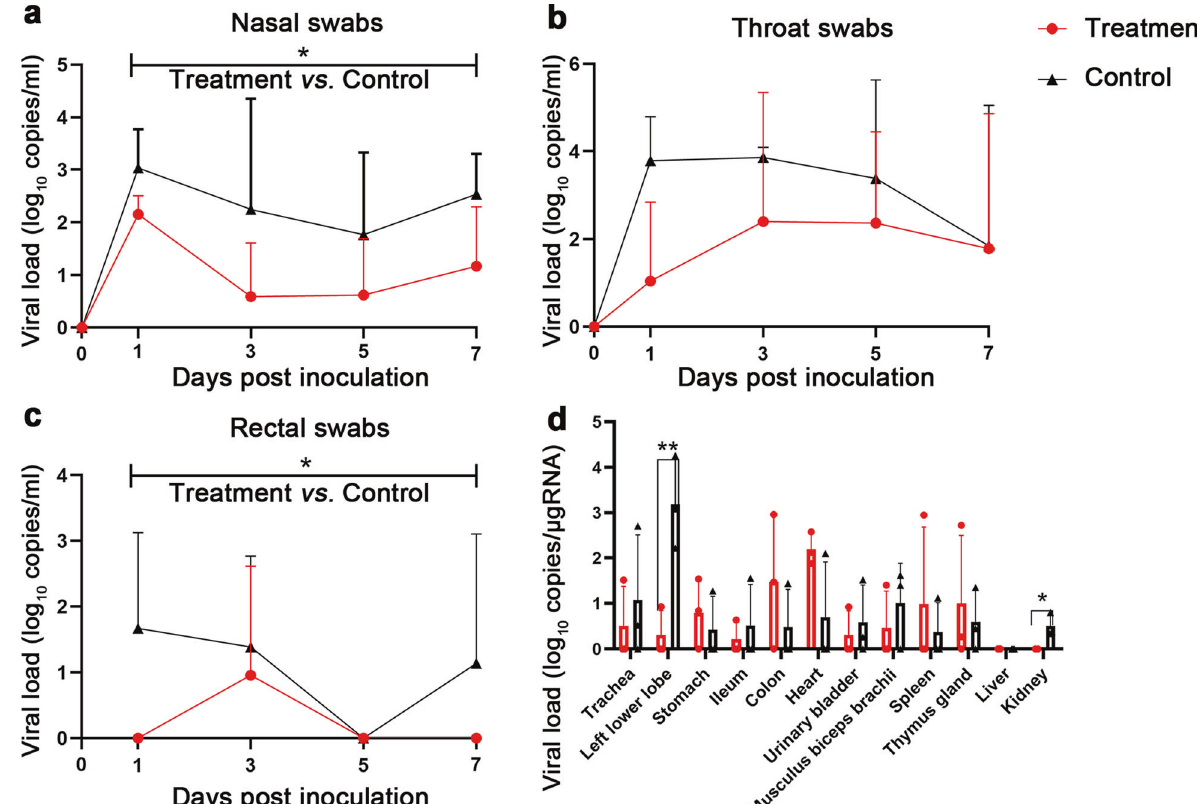
Fig. 2 a , b , c , d Viral loads in nasal ( a ), throat ( b ), rectal ( c ) swabs, and tissues ( d ) collected from SARS-CoV-2-infected rhesus macaques treated with nel fi navir ( n = 3) or vehicle solution ( n = 3). A 2-way mixed ANOVA ( a , b , and c ) or unpaired t -test ( d ) was used for statistical analysis